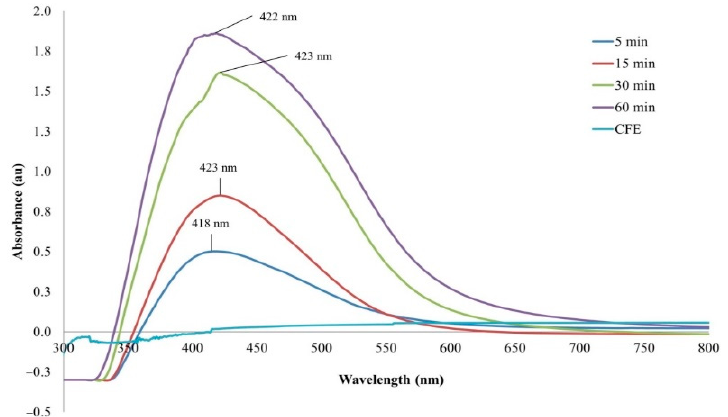
Figure 2. UV-Vis spectrum of Eh-AgNPs.